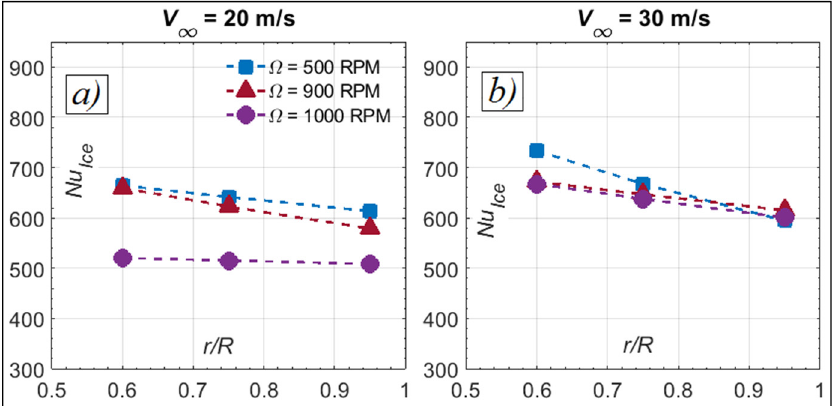
Figure 14. Variation in the Calculated Nu Ice with Respect to r/R for the De-Icing Tests with T ∝ ≈ 265.65 K and at ( a ) V ∝ = 20 m/s and ( b ) V ∝ = 30 m/s.